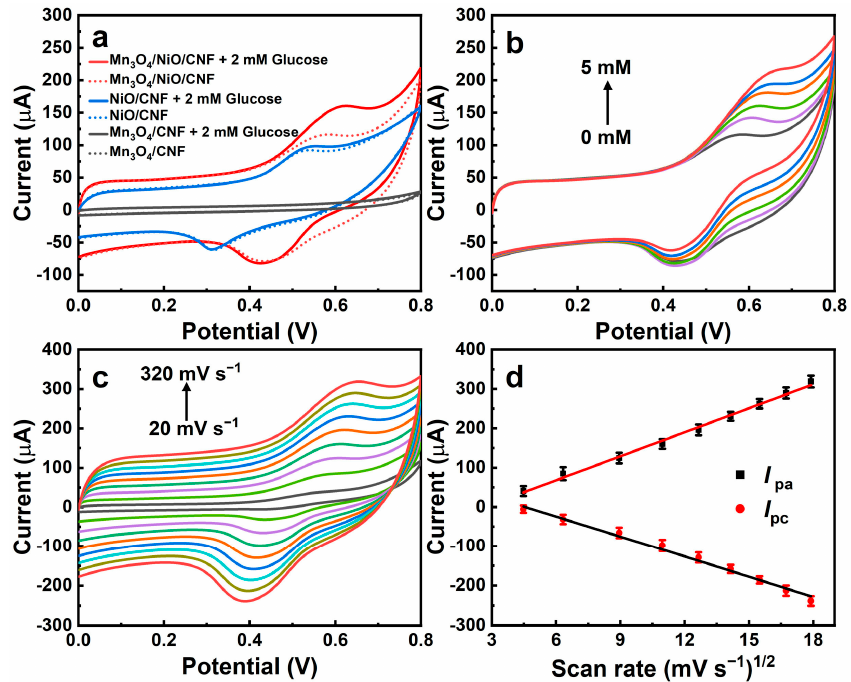
Figure 4. ( a ) CVs of Mn 3 O 4 /CNFs, NiO/CNFs, and Mn 3 O 4 /NiO/CNFs electrodes in the absence and presence of 2 mM glucose; ( b ) CVs of Mn 3 O 4 /NiO/CNFs electrode with different concentrations of glucose in 0.1 M NaOH at the scan rate of 100 mV s –1 ; ( c ) CVs of Mn 3 O 4 /NiO/CNFs electrode in the presence of 1 mM glucose at different scan rates; ( d ) peak currents in relationship to the square root of the scanning speed scan rate.